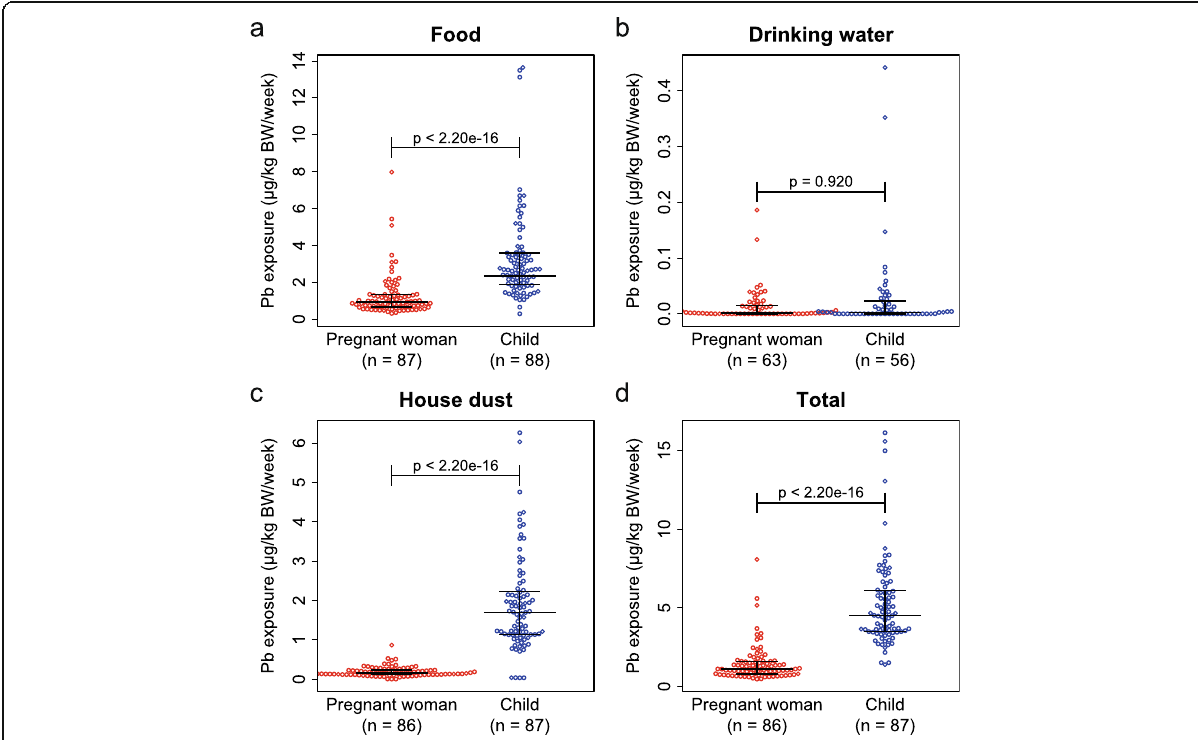
Fig. 1 Lead intake per body weight per week from food, drinking water, and house dust. Beeswarm plot of oral exposure of Pb adjusted to the body weight per week ( μ g/kg BW/week) from food samples ( a ), drinking water samples ( b ), house dust samples ( c ), and total lead exposure ( d ). Medians (longer horizontal bars in the middle) and 1st and 3rd quartiles (lower and higher horizontal bars, respectively) were indicated in the graphs. The p values were indicated in the graphs (WMW test)